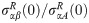
Mouse ESC-CN system shows a similar enhanced tendency of physical proximity for co-regulated genes with similar expression patterns.(A) Schematic diagram of the development from ESC to CN cells. (B) Dynamic regulatory map obtained through the DREM2 analysis. (C) Heat map of intra- (diagonal) and inter- (off-diagonal) HMM class gene densities within the first shell of radial distribution relative to the corresponding densities of all genes (as control) in ESC cells or CN cells (i.e., σαβR(0)/σαAR(0)). (D) Gene densities of all HMM classes within the first shell of radial distribution relative to the corresponding densities of all genes (i.e., σααR(0)/σαAR(0))) in ESC cells or CN cells.